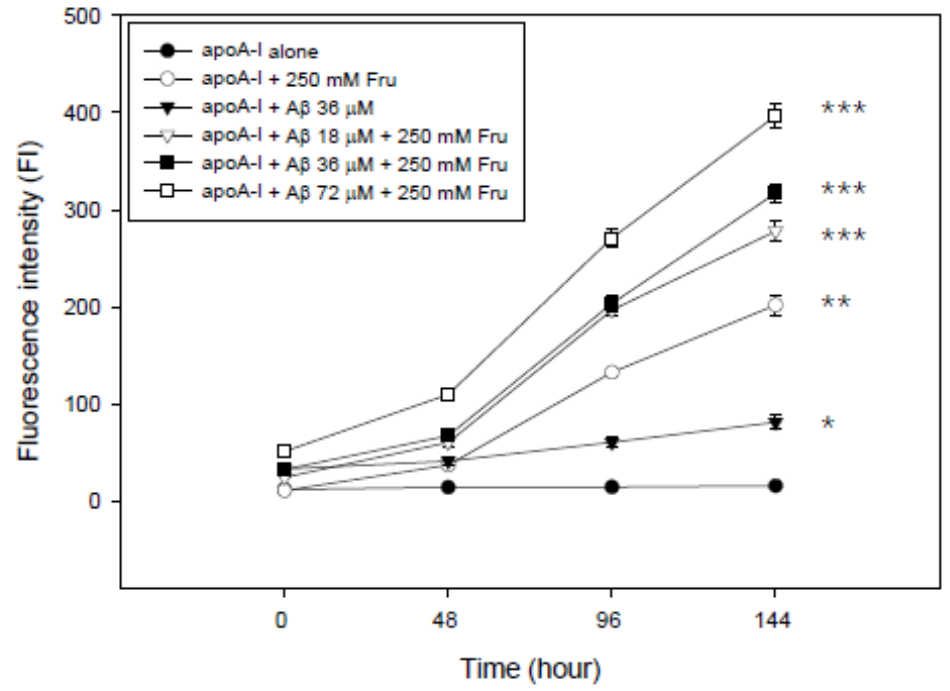
Figure 4. Synergistic increase in the extent of glycation by elevation of the A β content over 144 h in the presence of fructose (Fru, final 250 mM). *, p < 0.05 between apoA-I alone and apoA-I + A β 36 µ M; **, p < 0.01 between apoA-I alone and apoA-I + 250 mM Fru; ***, p < 0.001 between apoA-I alone and apoA-I + A β + 250 mM Fru.